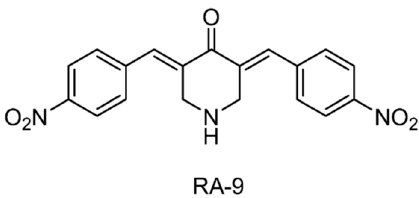
Figure 9. Structure of compound RA-9. The exact chemical structures of AM146 and RA-14